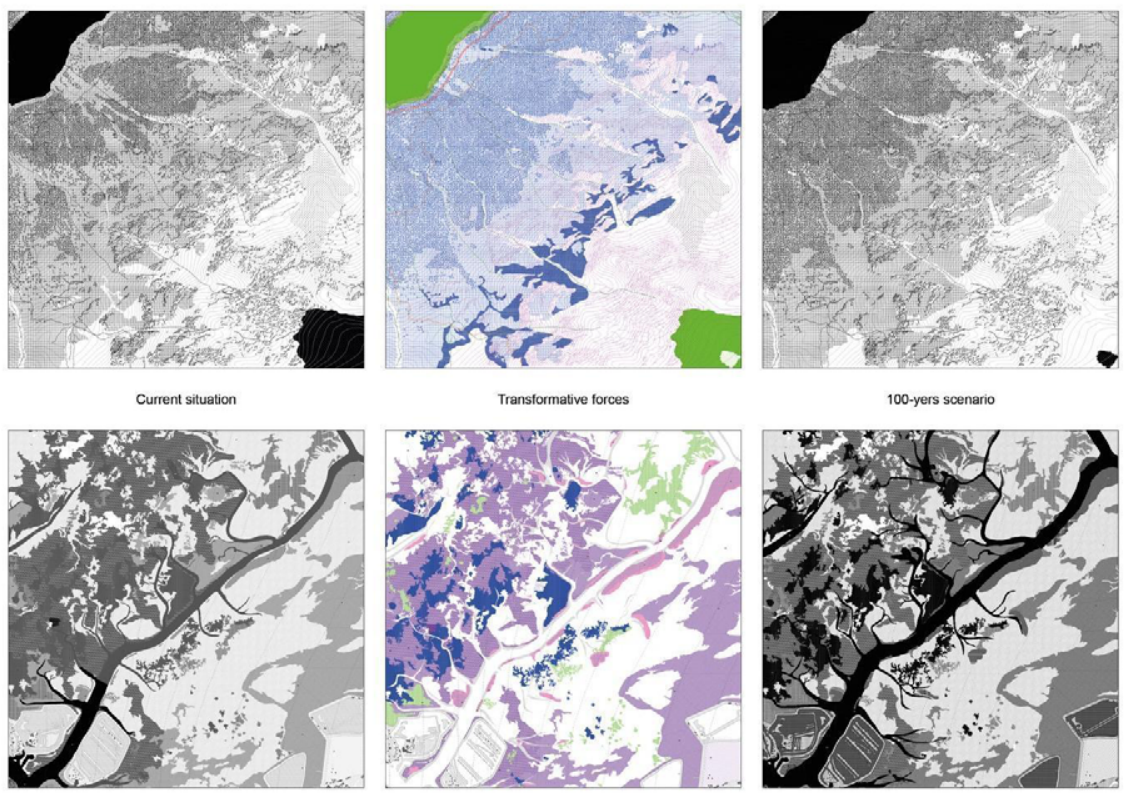
Two examples of the maps produced by students of the Final Master Studio at the Architecture Department of Ferrara. Above, the hypothetical 100-years evolution of the Gioveretto Glacier in the province of Bolzano, Italy (elaborated by Gianluca Sartin); below, the analogous period investigated for an area in the Grado Lagoon in Friuli-Venezia Giulia, Italy (elaborated by Yasmine